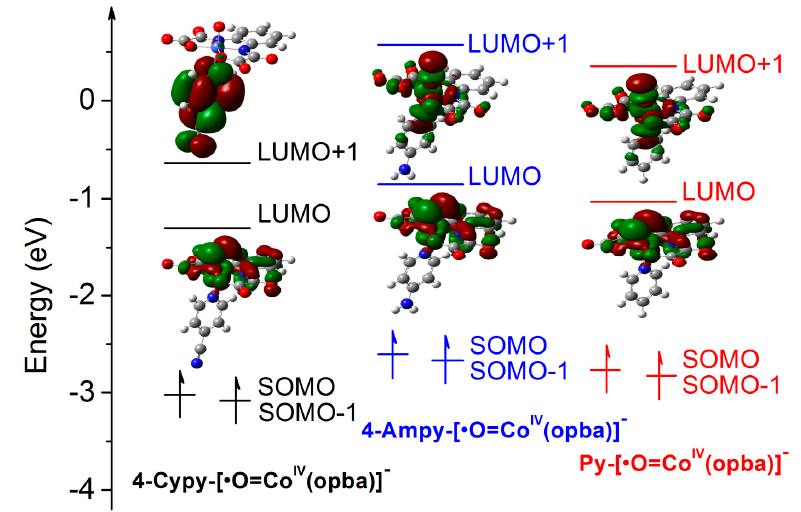
Figure 5. Energy level scheme for 4-Cypy-[•O=Co IV (opba)] − , 4-Ampy-[•O=Co IV (opba)] − and